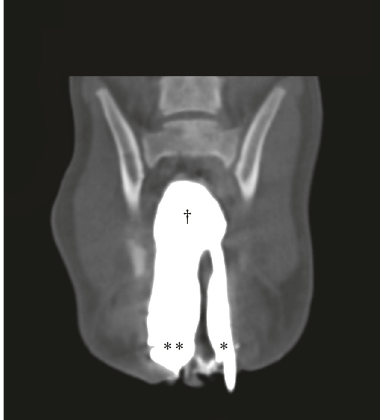
Figure 2: Dorsal plane CT image of the rectum with positive con- trast medium infused through two catheters in each anal opening left ( ∗∗ ) and right ( ∗ ). The contrast is distinctly separate caudally, proceeding cranially in the rectum, and then joins approximately 4.5 cm cranially ( † ).